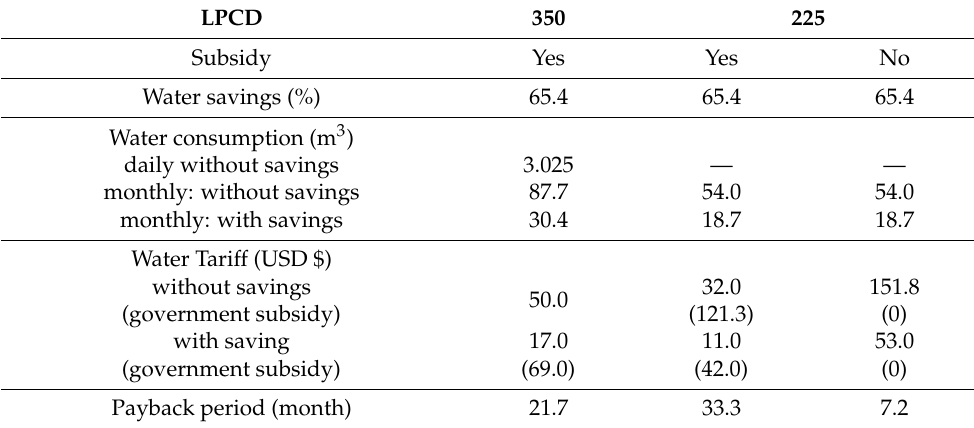
Table 5. The payback period for 350 LPCD and 225